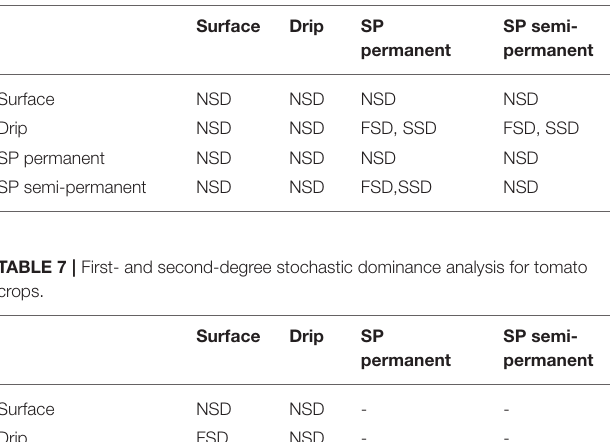
TABLE 6 | First- and second-degree stochastic dominance analysis for wheat crops.